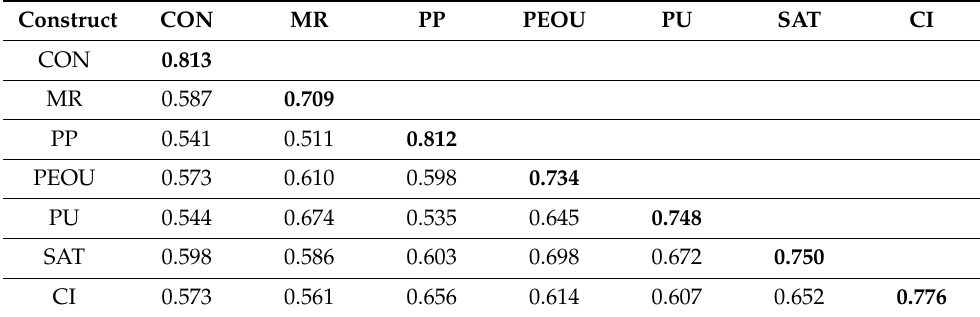
Table 3. Correlation matrix and AVE.